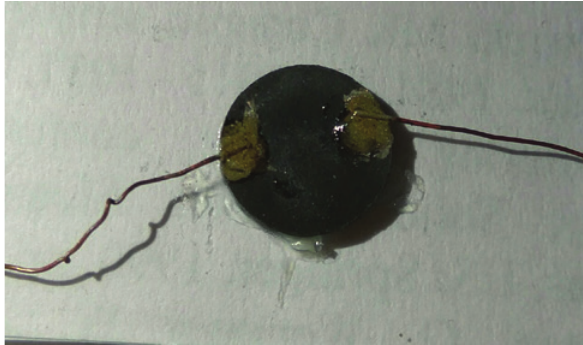
Figure 7: Photograph of developed humidity sensor based on the potash alum/carbon black composite.